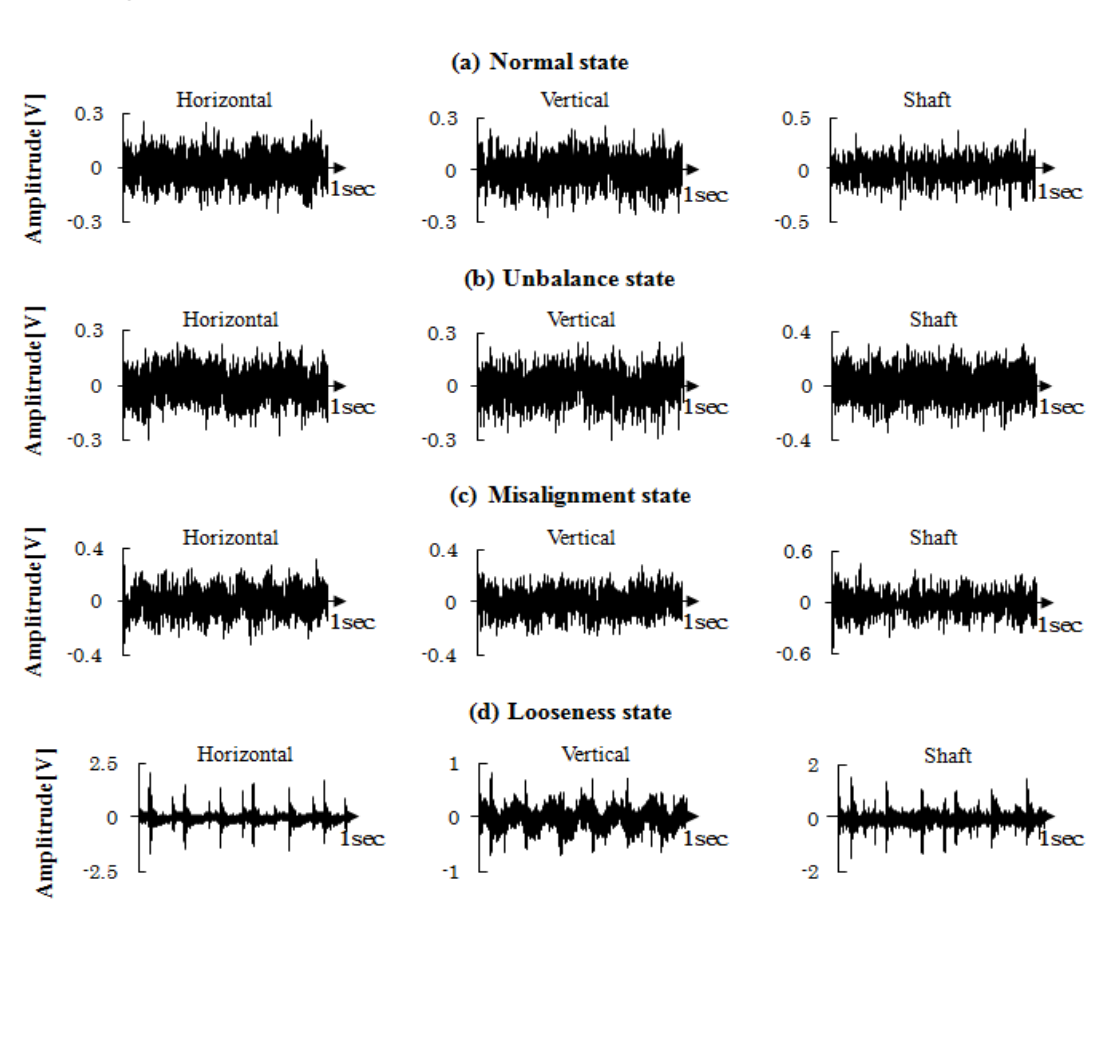
Figure 5. Raw vibration signals in time domain (a) Normal state, (b) Unbalance